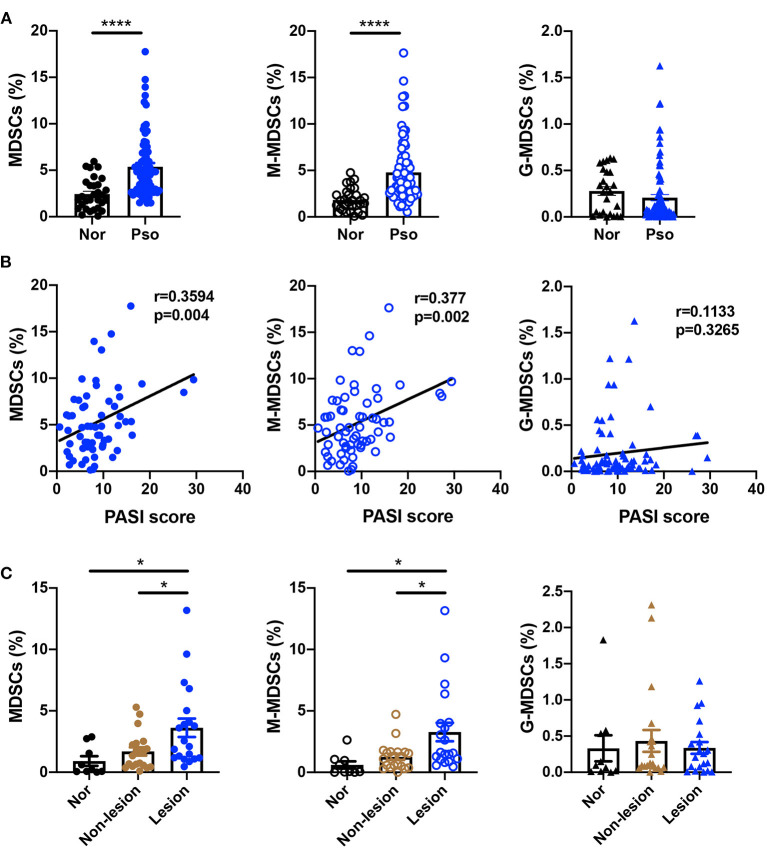
MDSCs and M-MDSCs expansion was found in the peripheral blood and skin lesions of psoriasis patients. (A,B) (A) Percentages of HLA-DR−CD11b+CD33+ MDSCs (left panel), HLA-DR−CD11b+CD33+CD15−CD14+ M-MDSCs (middle panel), and HLA-DR−CD11b+CD33+CD15+CD14− G-MDSCs (right panel) in PBMCs of healthy controls (Nor) (n = 30) and plaque psoriasis (Pso) (n = 77), and (B) the correlation analysis between the indicated cells frequency and disease activity (that is, PASI score) in plaque psoriasis. (C) The number of MDSCs (left panel), M-MDSCs (middle panel), and G-MDSCs (right panel) in normal skins (n = 9), non-lesion tissues (n = 20), and skin lesion of psoriasis (n = 20). Data represent the mean ± SEM. *p < 0.05, ****p < 0.0001.